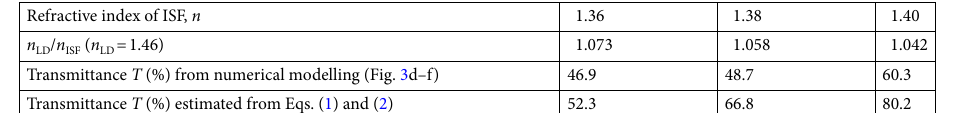
Refractive index of ISF, n n LD / n ISF ( n LD = 1.46) Transmittance T (%) from numerical modelling (Fig. 3d–f) Transmittance T (%) estimated from Eqs. (1) and Table 1. The collimated transmission of the light beam with a change in the refractive index mismatch between ISF and LD when integrating the output photonic jets over an area equal to the width (20 μm) of the undisturbed irradiating light beam at the bottom of the cell layer [see Fig. 3d–f] with a total thickness of 120 μm.